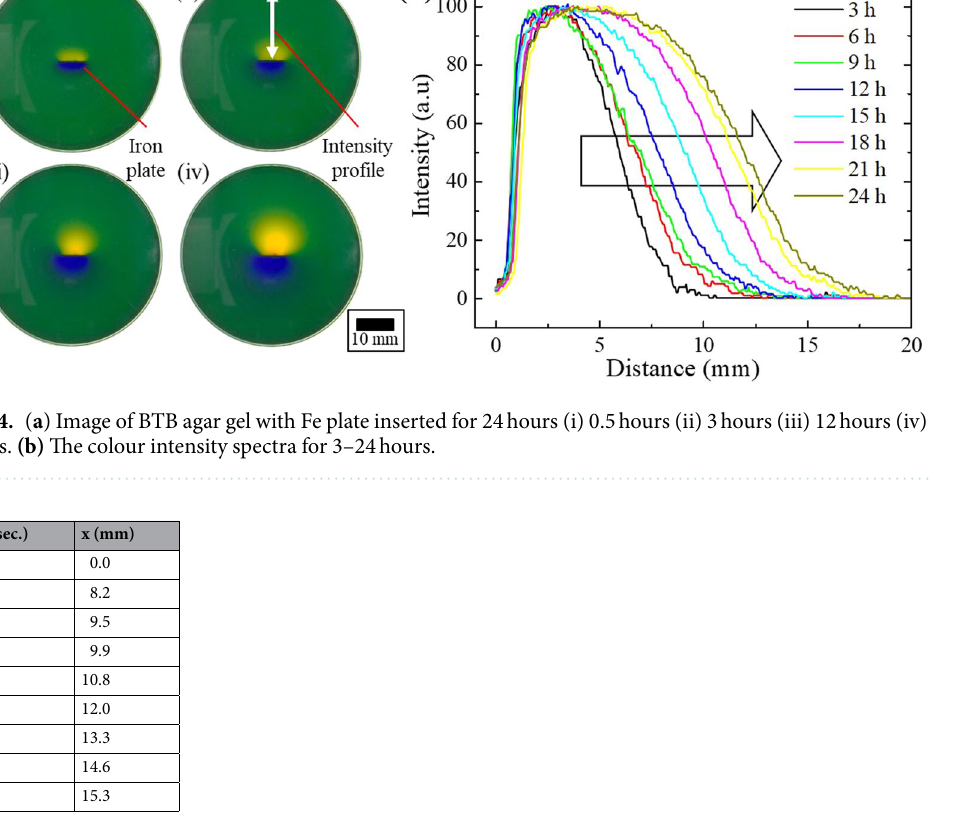
Table 1. The diffusion distance of protons from 10% intensity in Fig.